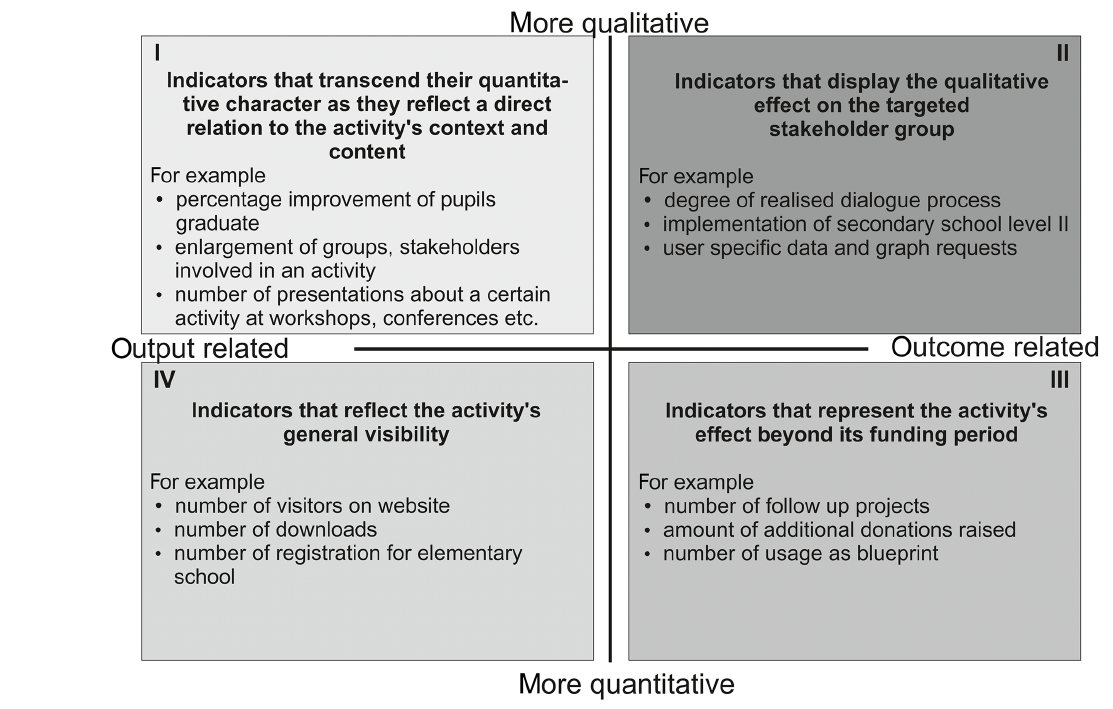
Figure 2. Principle classification scheme of indicators derived from three case examples in the field of knowledge transfer of REKLIM-HO and the Climate Office for Polar Regions and Sea Level